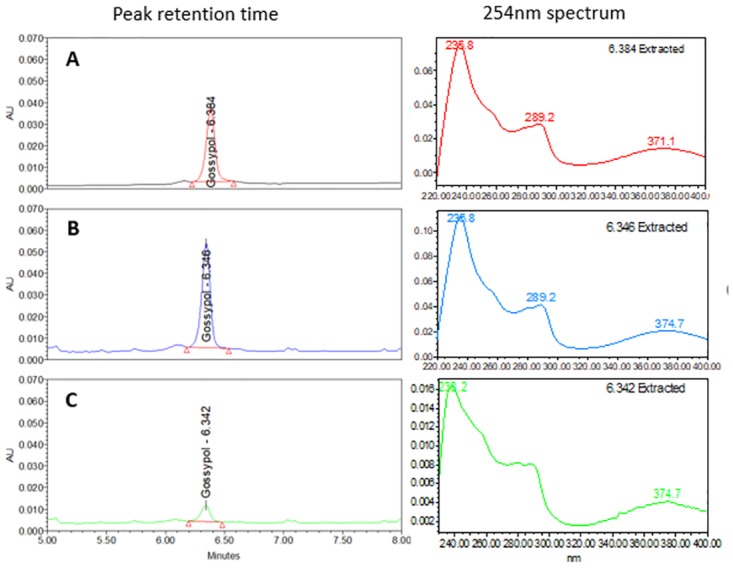
UHPLC chromatograms and respective spectra at 254 nm of gossypol from standard solution and cottonseed sample extracts.(A) Standard gossypol at 40μg/mL and its spectrum extracted at 6.384 min; (B) cottonseed sample spiked with standard gossypol (40μg/mL) and spectrum at 6.346 min; (C) cottonseed sample extract and spectrum at 6.342 min.